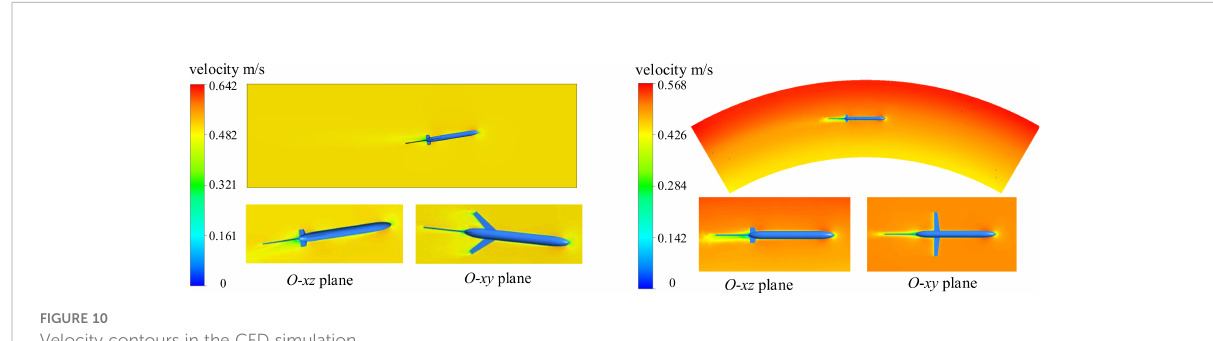
FIGURE 10 Velocity contours in the CFD